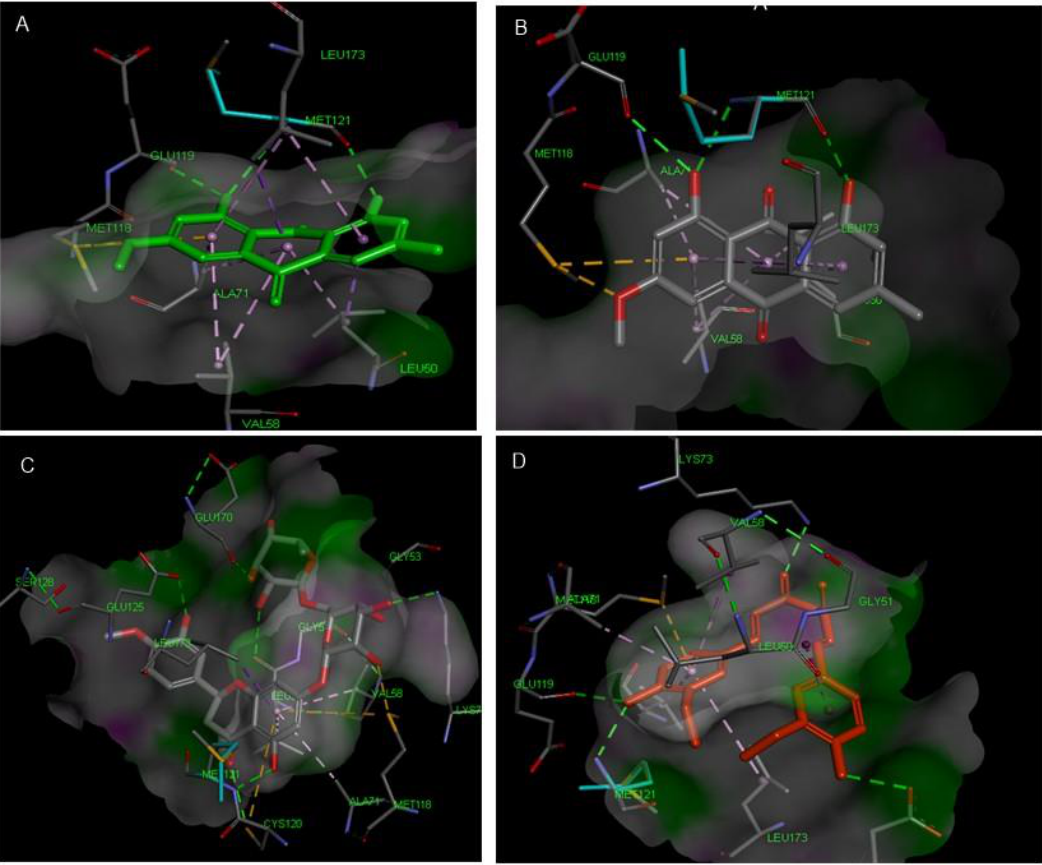
Figure 12. Interactions and binding energy of chrysophanol ( A ), physcion ( B ), hesperidin ( C ) and curcumin ( D ) with MK-3 MAPK (PDB ID: 3SHE).